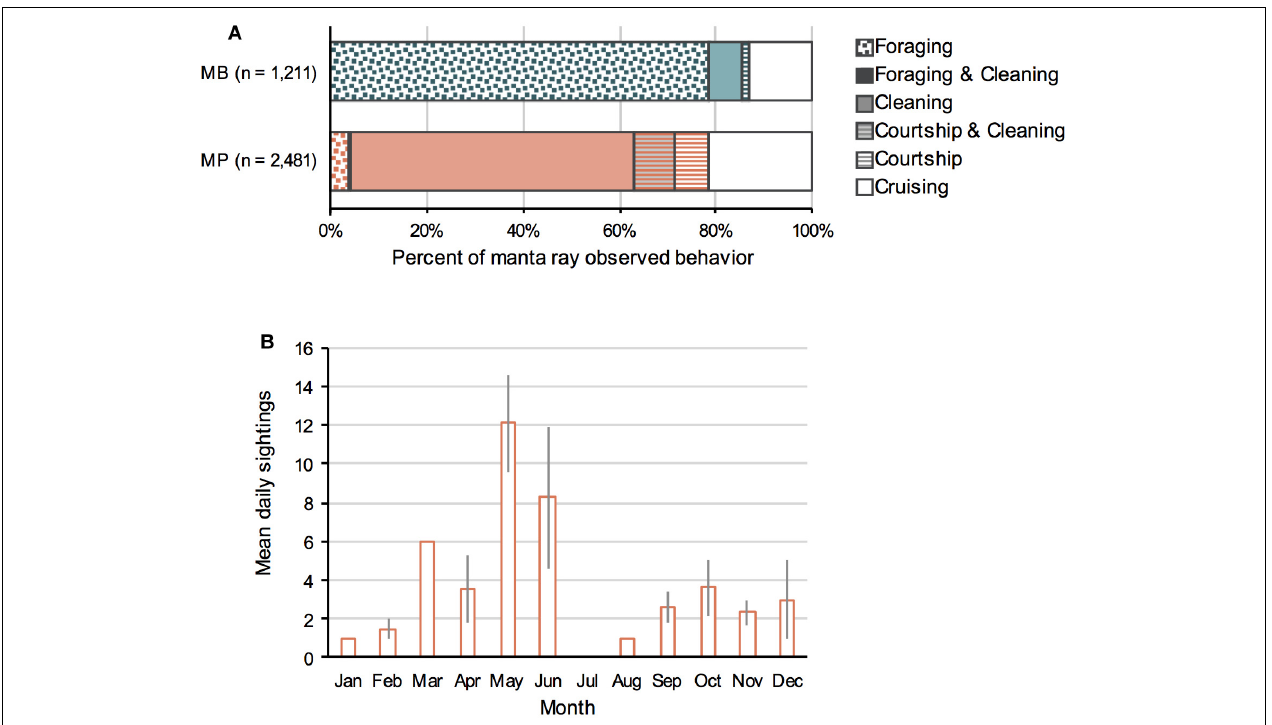
FIGURE 6 | (A) The percentage of observed manta ray behaviors determined from sighting logs and photographs from Manta Bay (MB, n = 1,211) and Manta Point (MP, n = 2,481) from January 2012 to April 2018. Foraging and cleaning, as well as courtship and cleaning behaviors by an individual manta ray were on occasion both witnessed during the same sampling event and identified as such. (B) The average monthly sightings per unit effort (day) of manta rays engaging in courtship behavior. Data recorded between 2013 and 2017 (excluding 2015 due to lower year-round effort) in MP and presented as the daily means ( ± 1